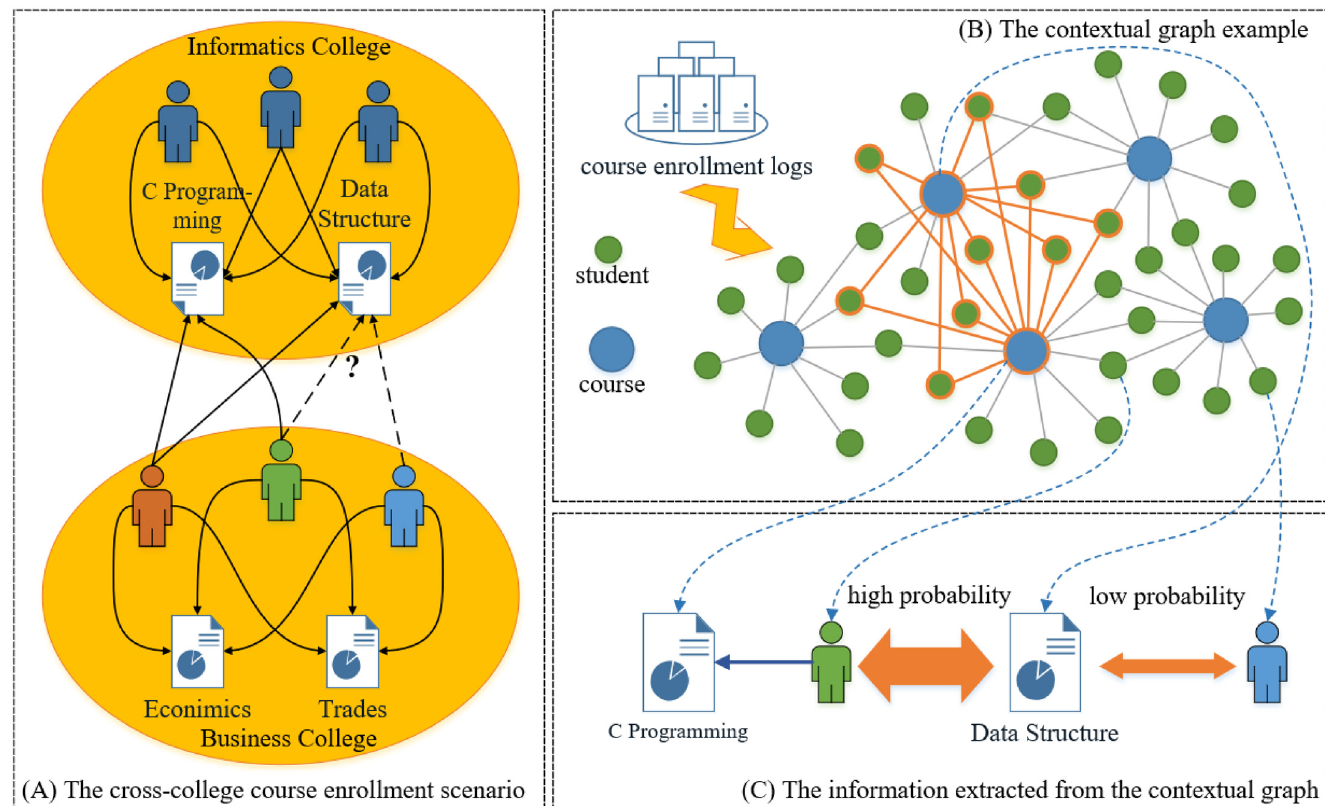
Fig 1. Framework of the proposed method. (A) The cross-collegecourse enrollment scenario.The characters in navy color represent students in the Informatics College,whereasthe characters in orange, green and blue s representstudents in the BusinessCollege.Of the three art-major students, the orangestudiedboth the Data Structure and C Programming , the green only enrolledin the C Programming , and the blue took none. (B) The contextual graph example.The two courses with thick edges represent the Data Structure and C Programming respectively, and the students with thick edges represent the ones who have studiedboth the two courses. (C) The information extracted from the contextualgraph. As the green has taken the C Programming , he/she will have more and shorter connectivity paths to the Data Structure than the blue, which can be describedas a